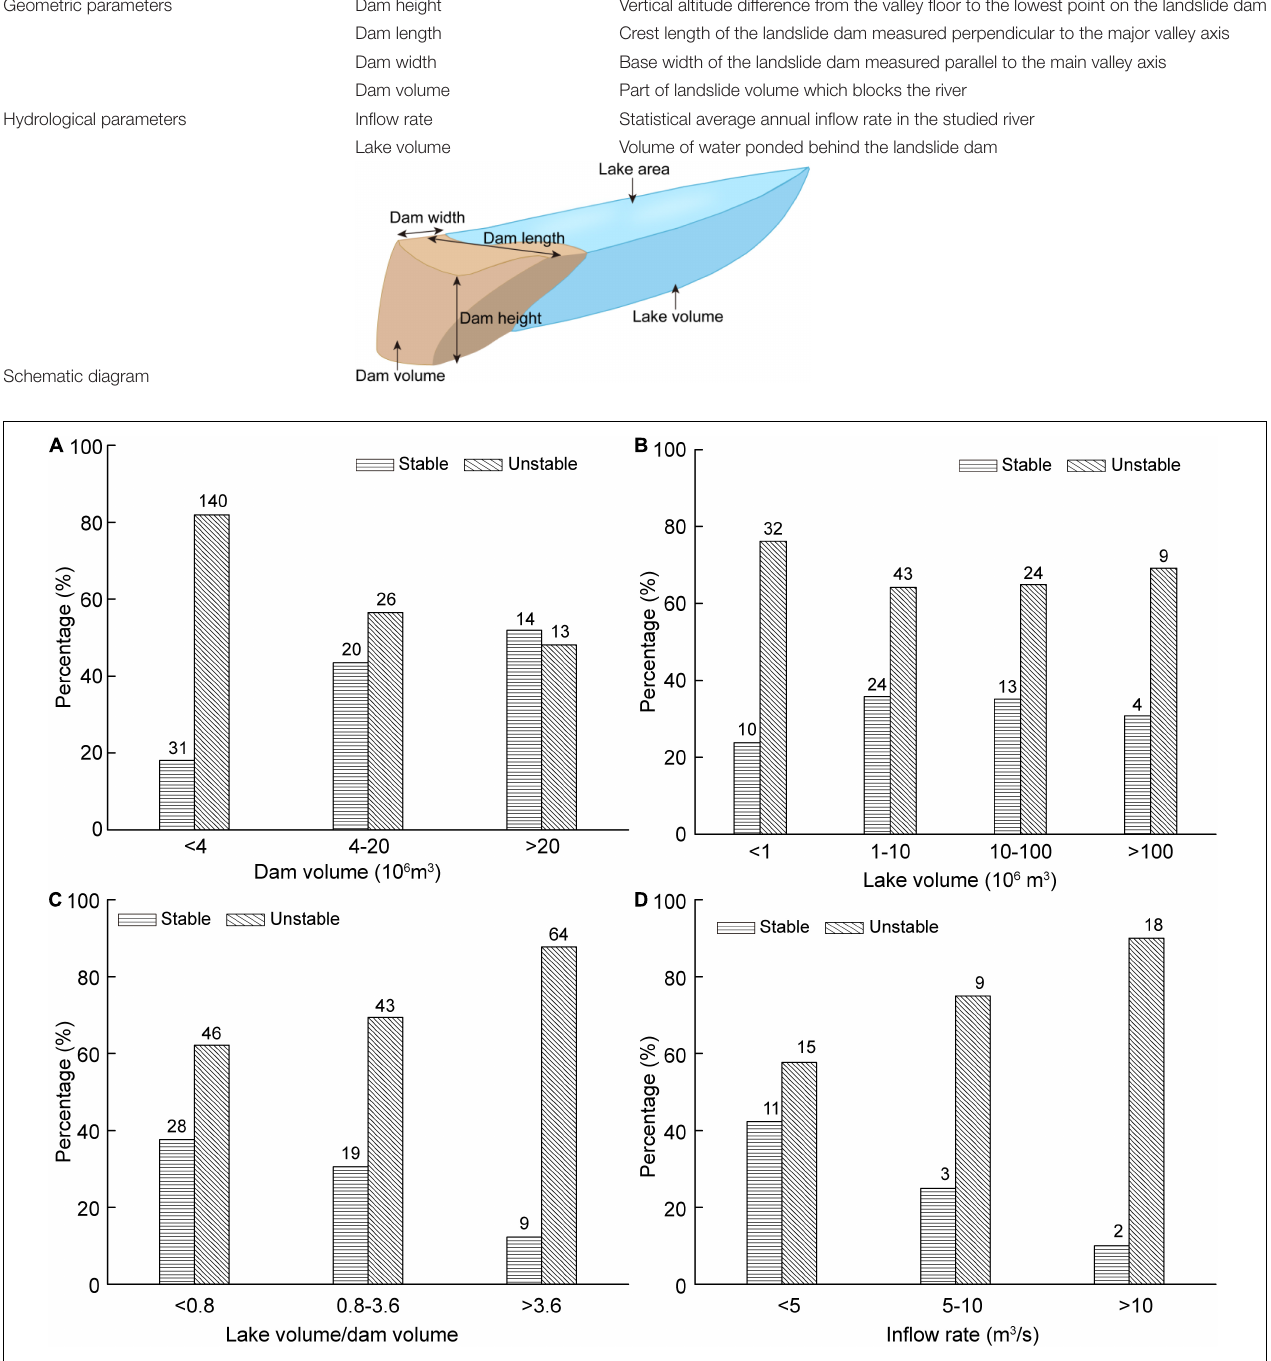
FIGURE 6 | Relationship between landslide dam stability and (A) dam volume, (B) lake volume, (C) the ratio of lake volume to dam volume width, and (D) inflow